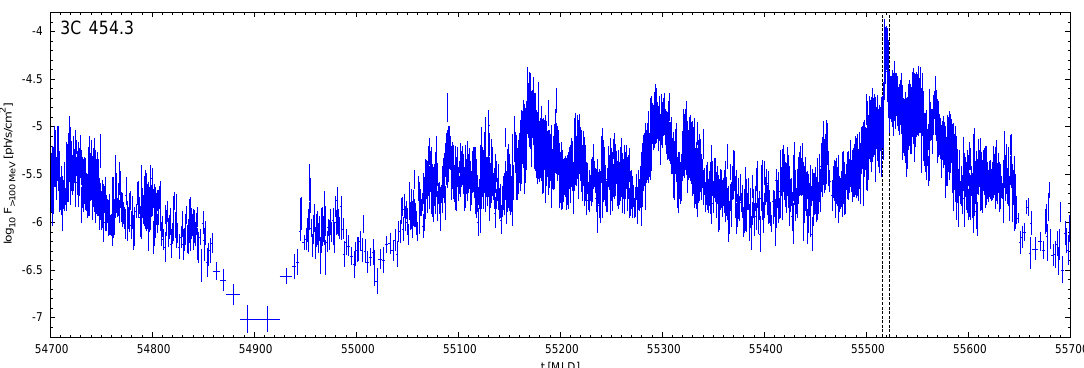
Figure 1. Long-term gamma-ray light curve ( E > 100 MeV) of blazar 3C 454.3 calculated from Fermi Large Area Telescope (LAT) data using adaptive time bins with Test Statistic (TS) > 25 [25]. The dashed vertical lines indicate the time range covered by Figure